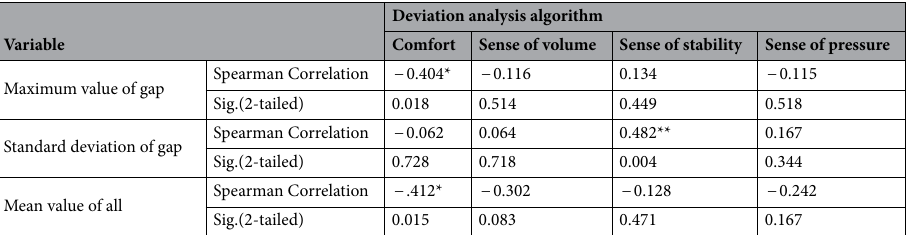
Table 4. Coefficient of spearman correlation between overall subjective evaluations and the results of deviation analysis algorithm. **Correlation is significant at the 0.01 level. *Correlation is significant at the 0.05